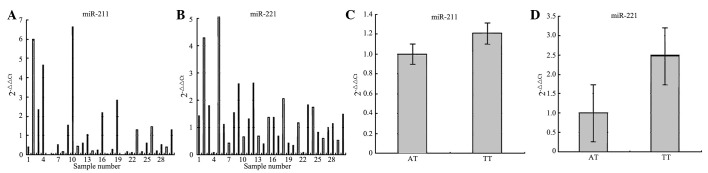
Individual (A, B) and general (C, D) relative quantification for miR-211 and miR-221 in tissue samples from patients with clear cell renal cell carcinoma (ccRCC). AT, adjacent tissue; TT, tumor tissue.